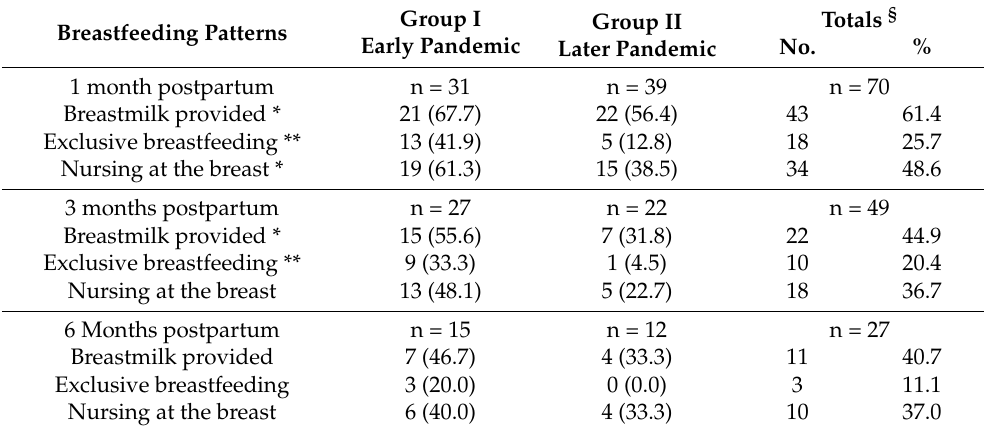
Table 5. Comparing breastfeeding rates among mothers in the early (2019–2020) and later (2020–2021) COVID-19 pandemic